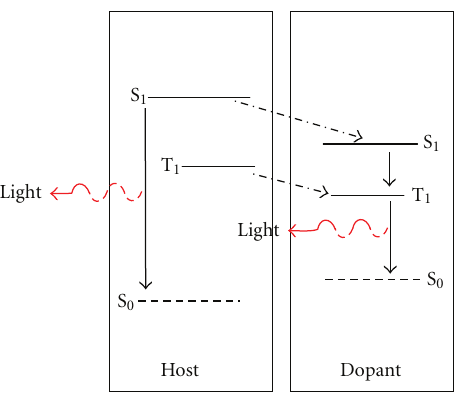
Figure 1: Energy structure between host and dopant in a PhOLED, S 1 represents the singlet excited states, T 1 the triplet excited states, and S 0 the ground